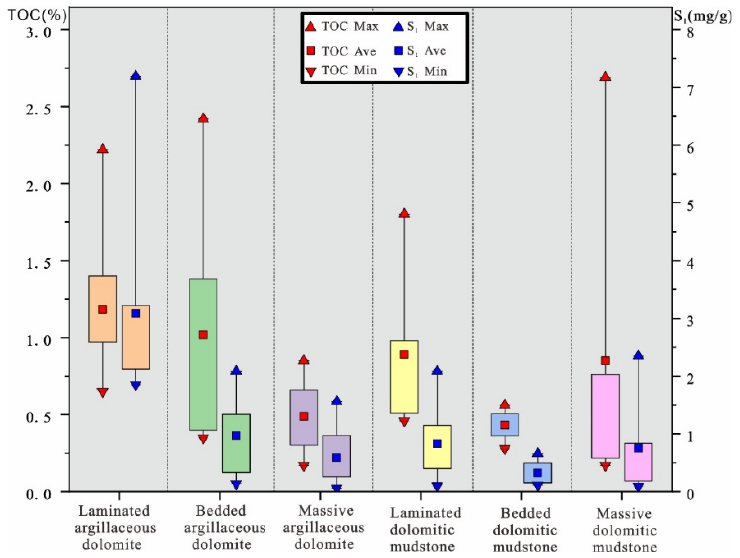
Figure 9. TOC and S 1 box diagram of different lithofacies in the lower member of Xingouzui Formation.